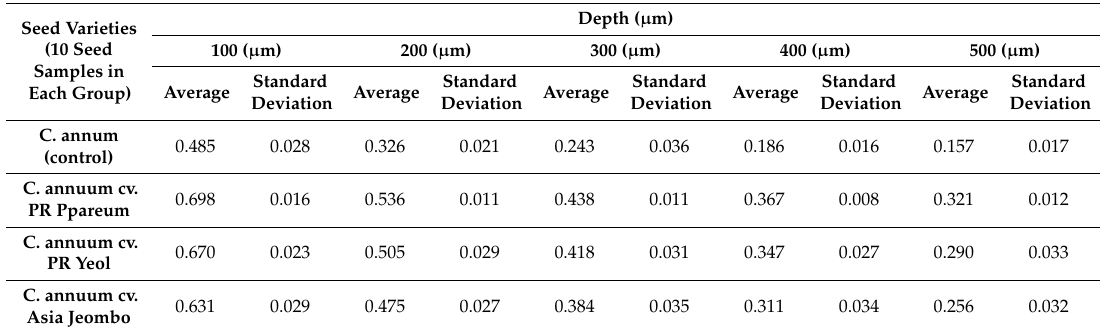
Table 1. Normalized intensity observed for control, C. annuum cv. PR Ppareum, C. annuum cv. PR Yeol and C. annuum cv. Asia Jeombo seed varieties at different depths in curve fitted plot derived from OCT images. Normalized Intensity Observed at Different Depths